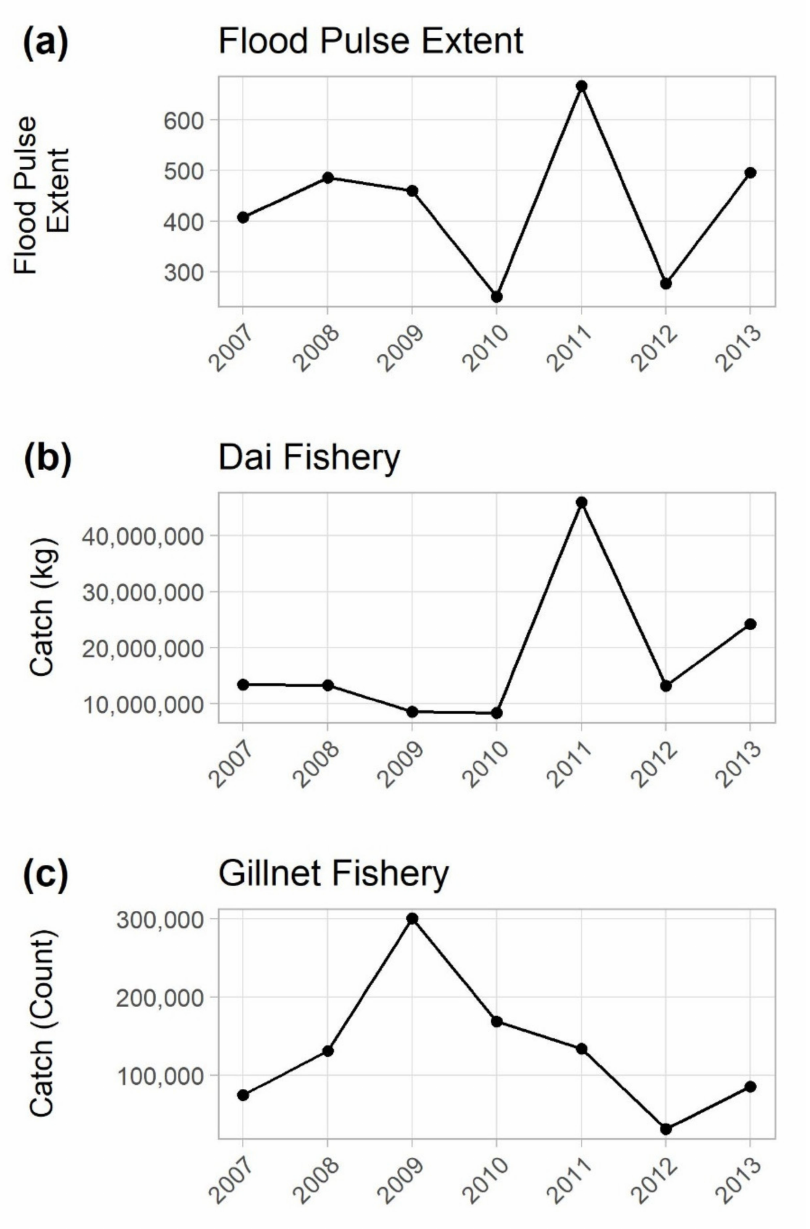
Figure 2. ( a ) Time series of the flood pulse extent (mean deviation from baseflows × number of days exceeding baseflows), ( b ) catch of the Dai fishery, and ( c ) catch of Gillnet